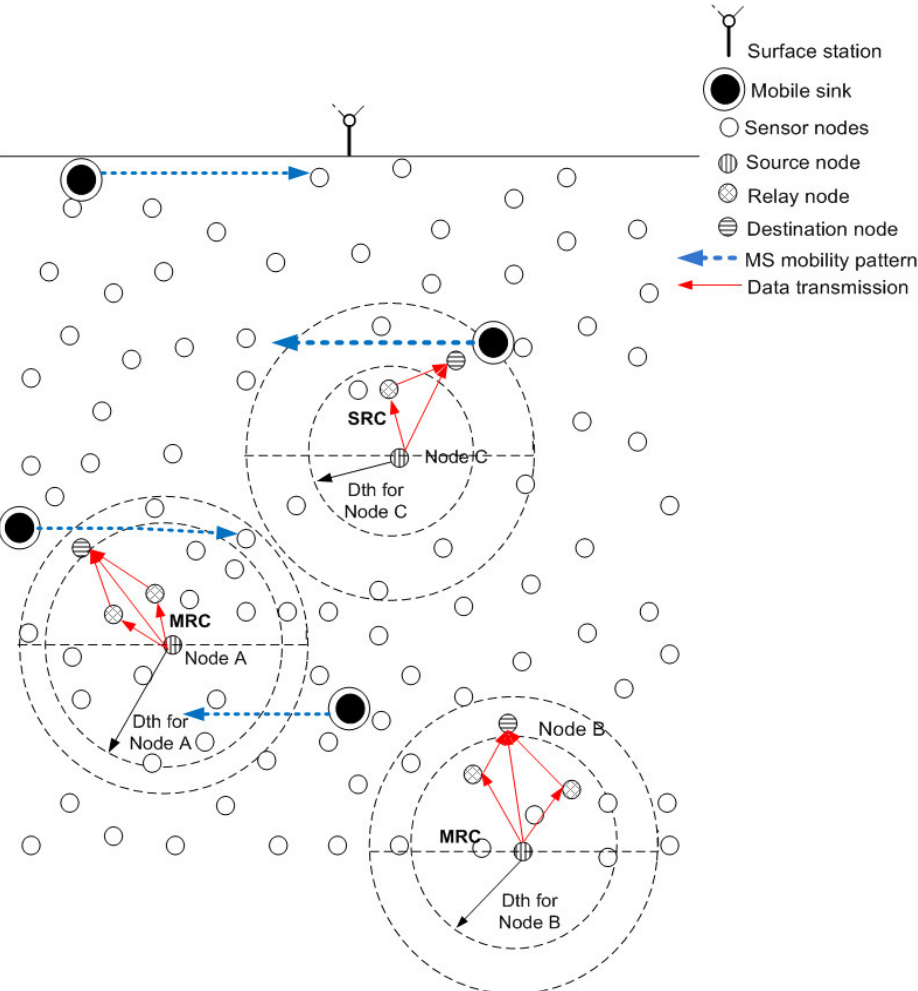
Figure 7. Data routing in the network with linear sink mobility